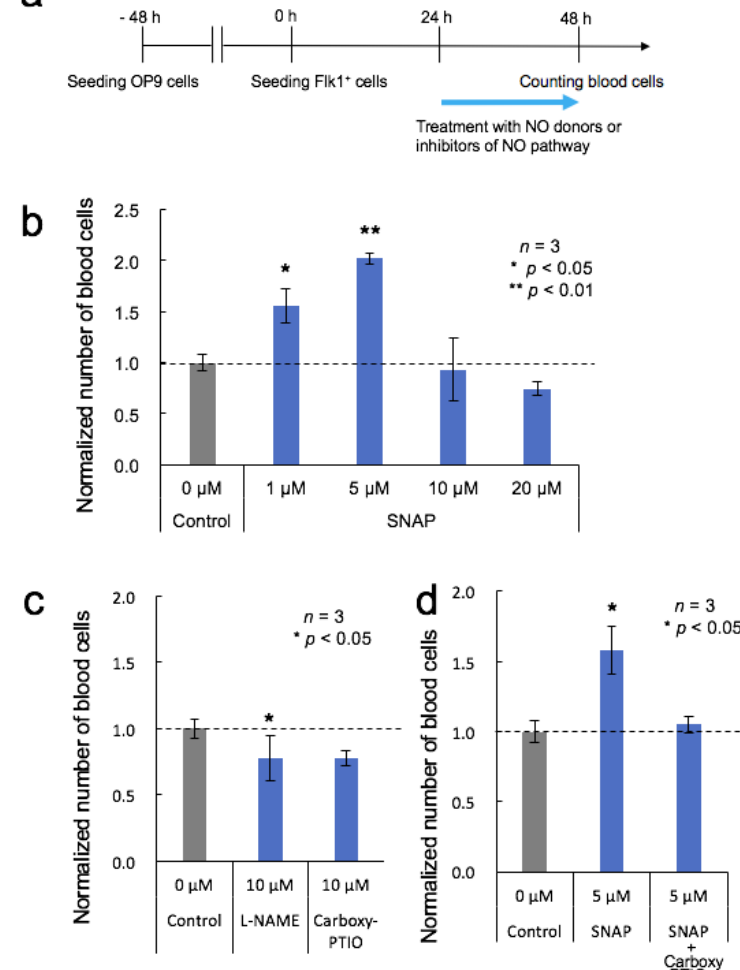
Figure 2. Effects of the nitric oxide (NO) donor and NO pathway inhibitors on blood cell generation. ( a ) Timeline of the di ff erentiation procedure and NO stimulation. ( b ) The number of blood cells arising from Flk-1 + cells untreated or treated with SNAP. Mean ± SD, one-way ANOVA, *: p < 0.05, **: p < 0.01, n = 3. ( c ) The number of blood cells arising from Flk-1 + cells untreated or treated with L-NAME or 2-(4-Carboxyphenyl)-4,4,5,5-tetramethylimidazoline-1-oxyl-3-oxide (Carboxy-PTIO). Mean ± SD, significant versus control, t -test, *: p < 0.05, n = 3. ( d ) The number of blood cells arising from Flk-1 + cells untreated or treated with SNAP or the combination of SNAP and Carboxy-PTIO. Mean ± SD, significant versus control, t -test, *: p < 0.05, n =